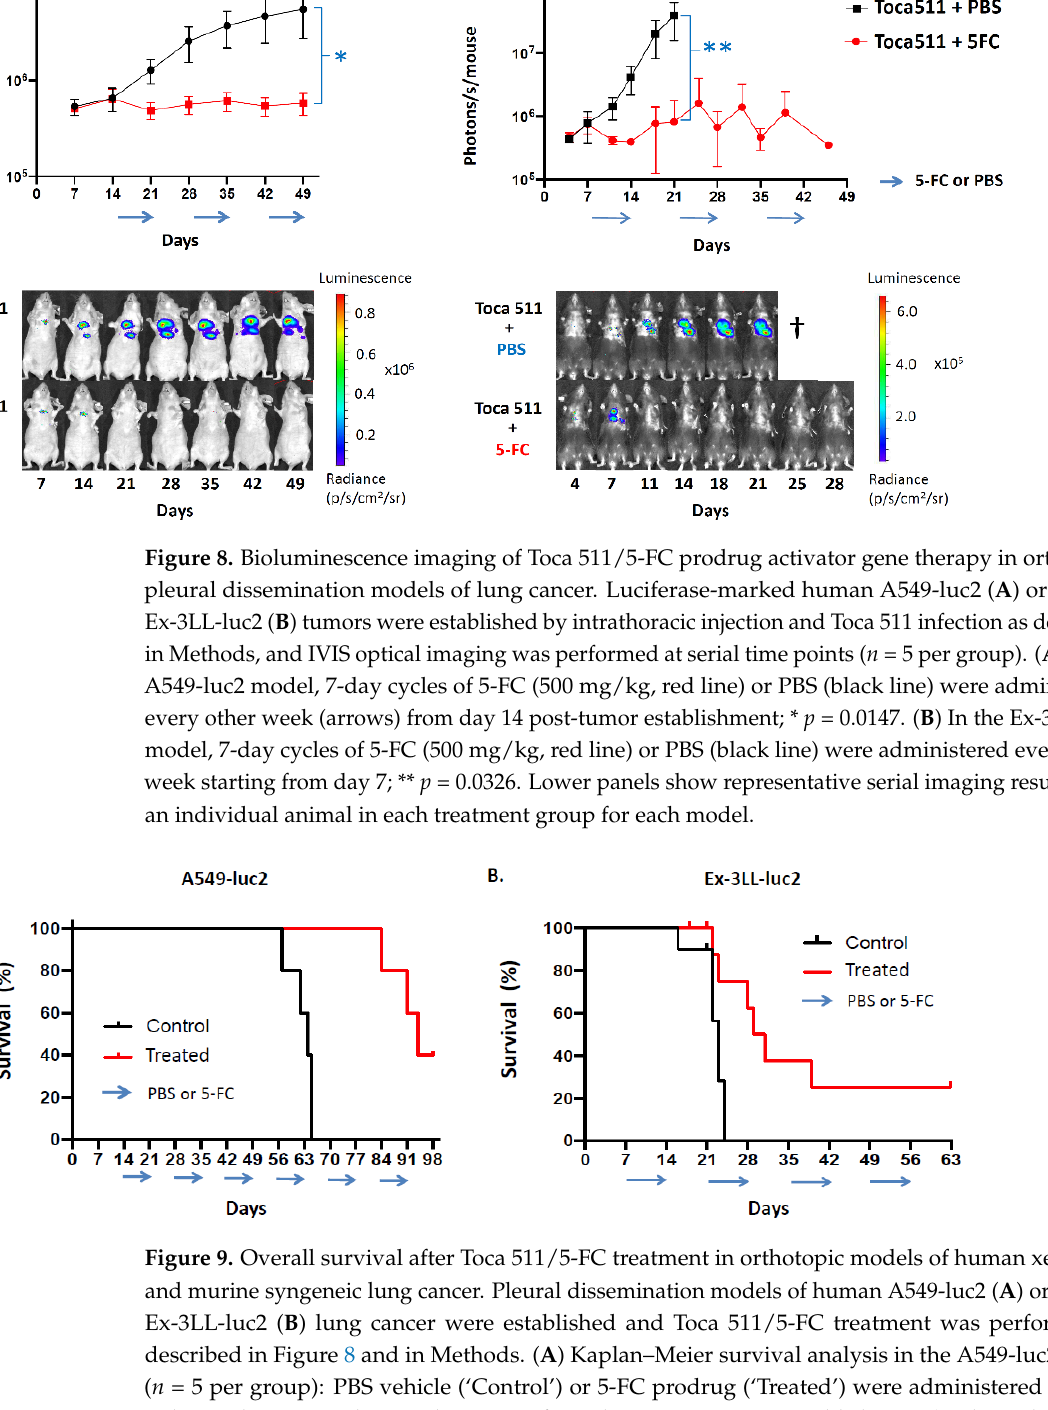
Figure 9. Overall survival after Toca 511/5-FC treatment in orthotopic models of human xenograft and murine syngeneic lung cancer. Pleural dissemination models of human A549-luc2 ( A ) or murine Ex-3LL-luc2 ( B ) lung cancer were established and Toca 511/5-FC treatment was performed as described in Figure 8 and in Methods. ( A ) Kaplan–Meier survival analysis in the A549-luc2 model ( n = 5 per group): PBS vehicle (‘Control’) or 5-FC prodrug (‘Treated’) were administered daily in 7-day cycles every other week, starting from day 14 post-tumor establishment (cycles indicated by arrows). ( B ) Kaplan–Meier survival analysis in the Ex-3LL-luc2 model ( n = 10 per group): PBS vehicle (‘Control’) or 5-FC prodrug (‘Treated’) were administered daily in 7-day cycles every other week, starting from day 7 post-tumor establishment